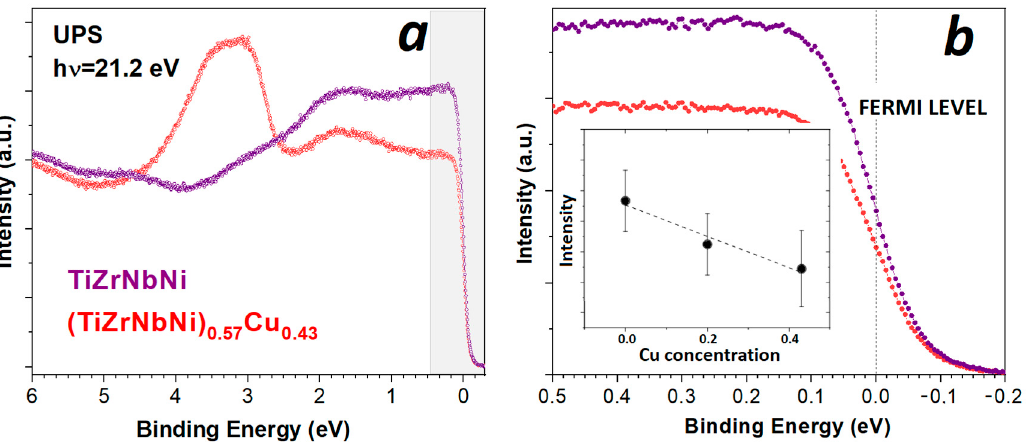
Figure 6. UPS of TiZrNbNi and (TiZrNbNi) 0.57 Cu 0.43 showing ( a ) valence band region; ( b ) expanded region (grey area in ( a )) around Fermi level, with inset indicating the change in the spectral intensity at the Fermi level for different concentrations of Cu.